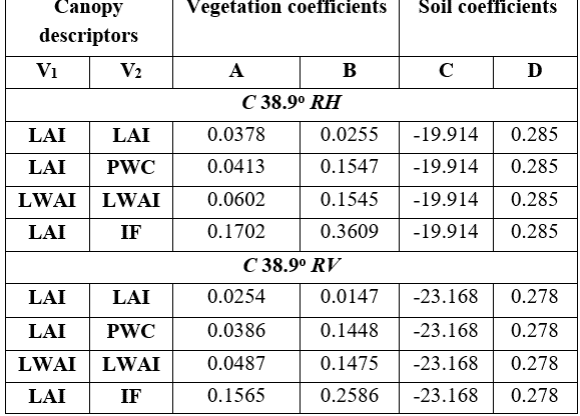
Table 3. Vegetation and soil coefficients for different models